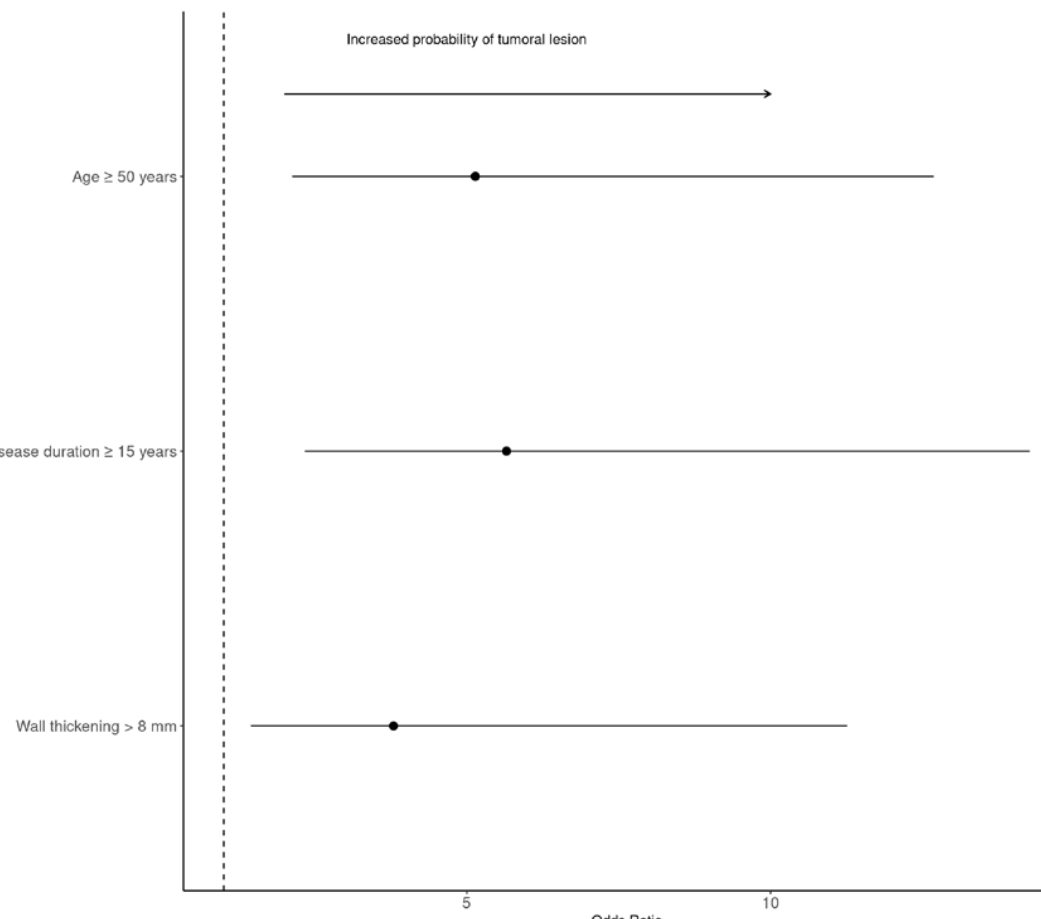
Figure 3. Forest plot of the probability of small bowel adenocarcinoma. Data are odds ratios; 95% confidence intervals are indicated by error bars.